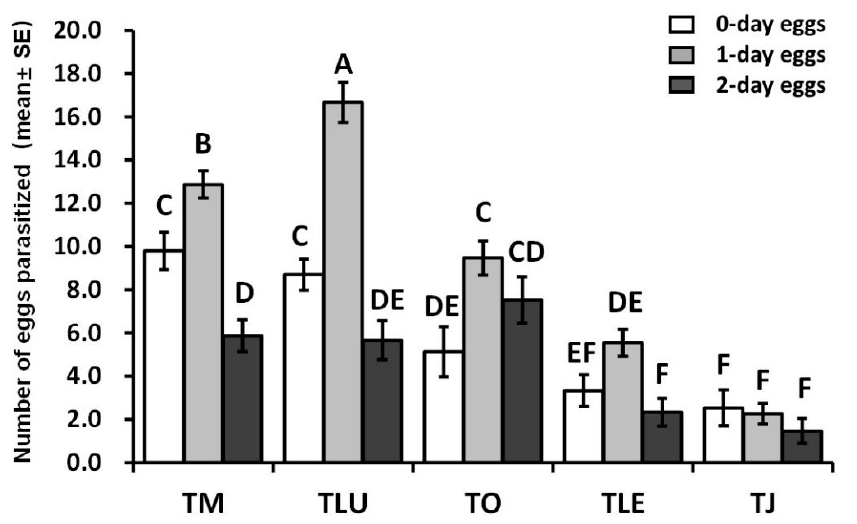
Figure 3. Mean number of FAW eggs parasitized by the five parasitoid species within a 24 h period at various host egg ages. (Different upper-case letters above group bars indicate significant difference ( p < 0.05, one way ANOVA followed by Tukey’s test) in number of parasitized eggs among the five species using eggs of different ages.). TM: T. mwanzai ; TLU: T. lutea ; TO: T. ostriniae ; TLE: T. leucaniae ; TJ: T. japonicum